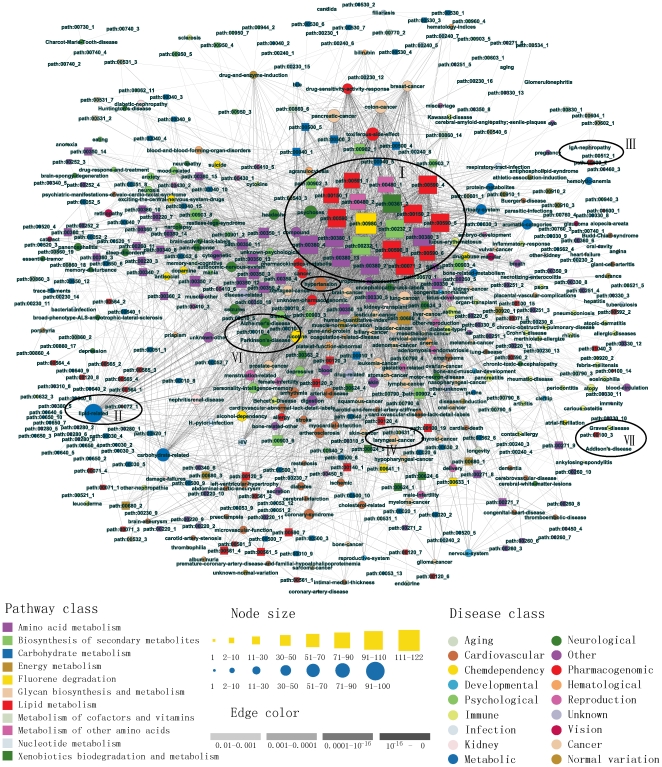
The DMSPN is a bipartite network.The circles and rectangles in the network correspond to diseases and metabolic subpathways respectively. A disease and a subpathway are connected by an edge if the set of disease genes are statistically significantly enriched to the corresponding subpathway. Node size is proportional to the degree of the node. Nodes are colored according to their categories, which include 18 disease classes from the Genetic Association Database (GAD) for disease nodes and 11 subpathway classes from the Kyoto Encyclopedia of Genes and Genomes (KEGG) pathway database for metabolic subpathway nodes. Edges are colored according to the enrichment significance (P-values) of associations between diseases and subpathways.